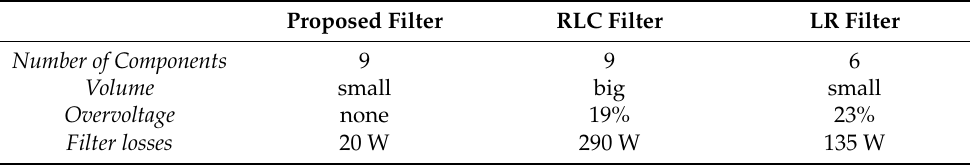
Figure 15. Output voltage of inverter ( a ) and terminal voltage at motor side with the proposed DM filter ( b ), RLC filter ( c ), LR filter ( d ). Table 6. Comparison between proposed filter and conventional